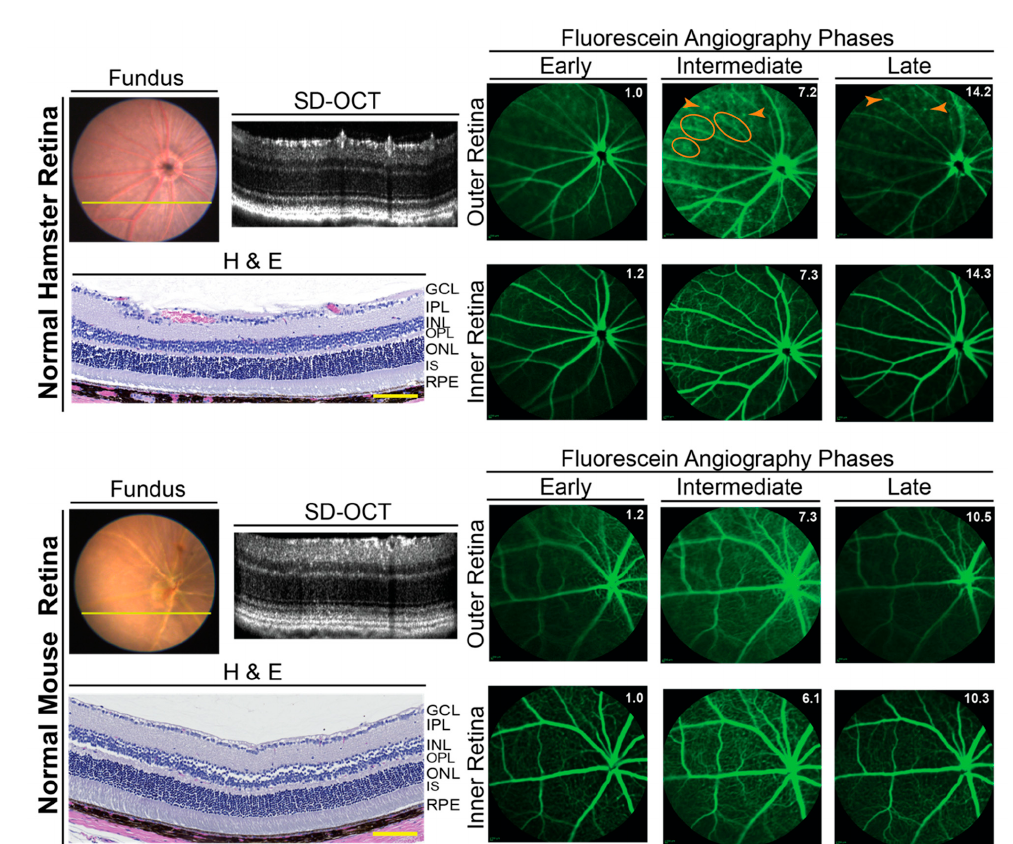
Figure 2. In vivo imaging of hamster and mouse retina. Representative (9 female and 9 male hamsters at 3 months of age; 9 female and 9 male hamsters at 6 months of age; 6 female and 6 male mice at 6 months of age) assessments by fundus color imaging (Fundus), spectral domain-optical coherence tomography (SD-OCT), and fundus fluorescein angiography after an injection with sodium fluorescein. No sex- and age-dependent differences were detected, hence only images of male animals are shown. The same representative animal (hamster or mouse) was used for the acquisition of all images. The SD-OCT panels shows retinal cross sections. Histology of the retinal cross sections after H&E stains is shown for comparison. The fluorescein angiography panels show an early-, intermediate-, and late-stage fundus fluorescence (from left to right) as defined by the post-injection time of image acquisition. This time (in minutes) is shown as white numbers in the upper right corner of each panel. The laser beam was focused on either the outer retina or inner retina, which are nourished by the choroidal and intraretinal vascular networks, respectively. Orange ovals and arrowheads on fluorescein angiography indicate diffused margins of some of the retinal capillaries and bright fluorescent spots, respectively. The retinal layer labeling is as described in Figure 1. GCL, the ganglion cell layer. Scale bars = 100 µ